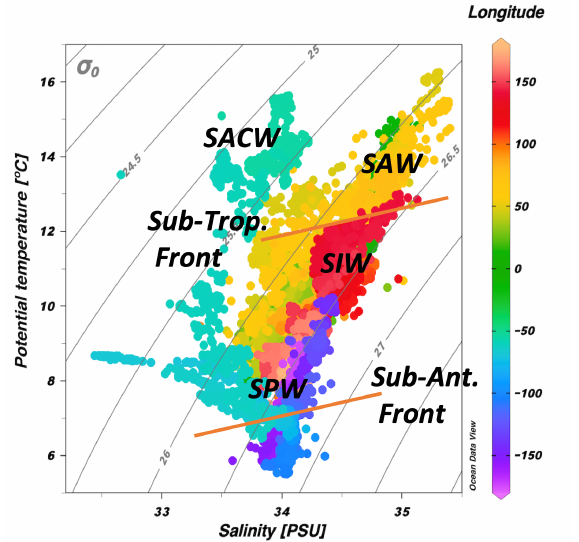
Figure 6. Temperature − Salinity diagram of surface in-situ filtered data showing the water masses: Southern Indian Waters (SIW), Southern Pacific Waters (SPW), SubAntarctic Waters (SAW) and South Atlantic Central Waters (SAW), and fronts found along the trajectory. Isopycnals ( σ θ ) are shown and colours correspond to the longitude ( ◦ ) as shown in the right side colourbar.